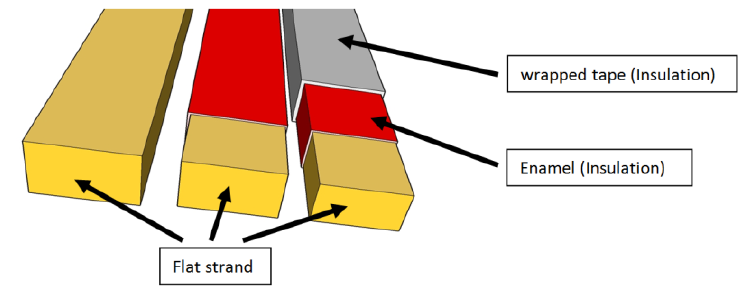
Figure 10. Three situations can be found about the strand insulation. From the left to the right, no insulation, an enamel coating with or without an additional tape (fiberglass without mica).